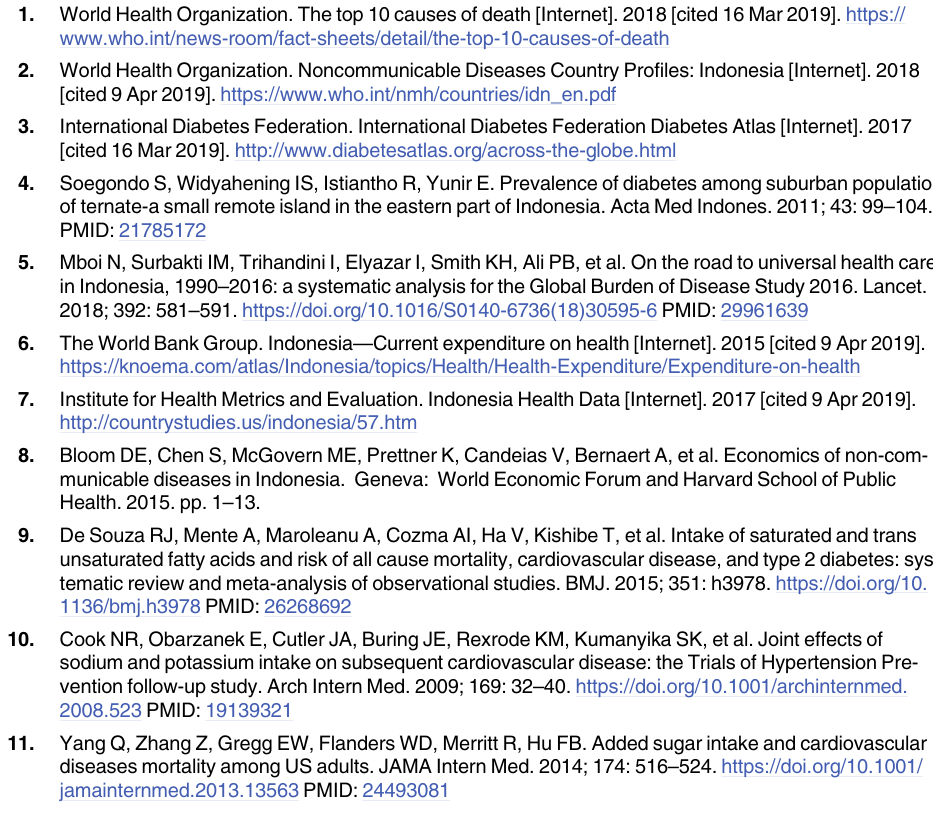
S7 Table. Multivariable Logistic Regression Testing the association between selected char- acteristics and Type 2 diabetes among adults in Indonesia,